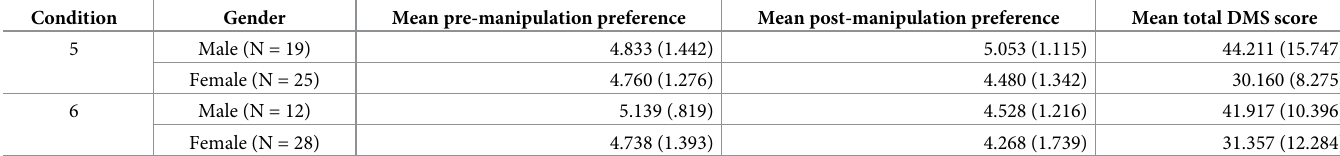
Table 5. Tabulated mean (standard deviation) pre- and post-manipulation preference for muscularity scores, and total DMS scores for each gender across the two manipulation conditions. Condition